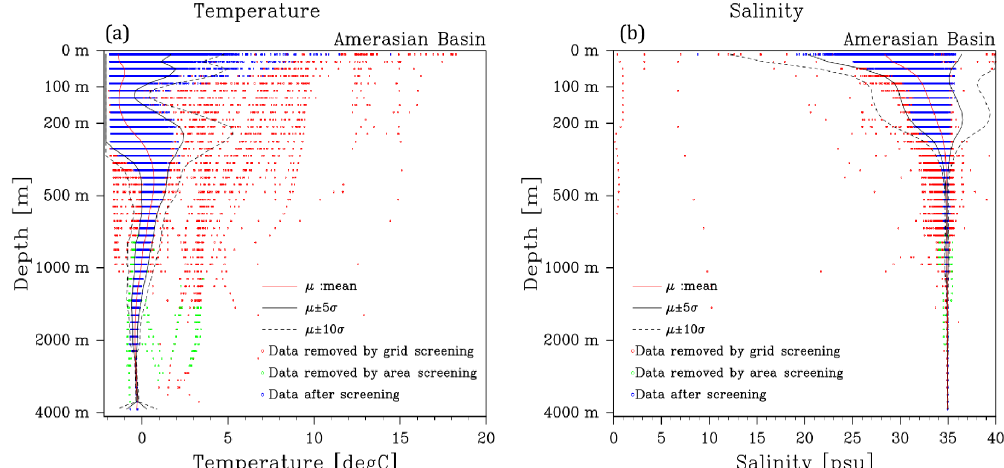
Figure 3. Temperature (a) and salinity (b) distributions versus depth (m) in the Amerasian Basin (see Fig. 2b for area definition) after a combined statistical screening. The blue dots denote data distribution after the screening, while the red (green) dots denote data removed by grid-based (area-based) statistical screening. The red line denotes the mean ( µ ) at each depth level after the screening, and the solid and dotted black lines indicate µ ± 5 σ and µ ± 10 σ , respectively. The mean and standard deviations are calculated by the data from the entire Amerasian Basin. Note that analyses in Sects. 3 and 4 use data from the 0 to 400m depth